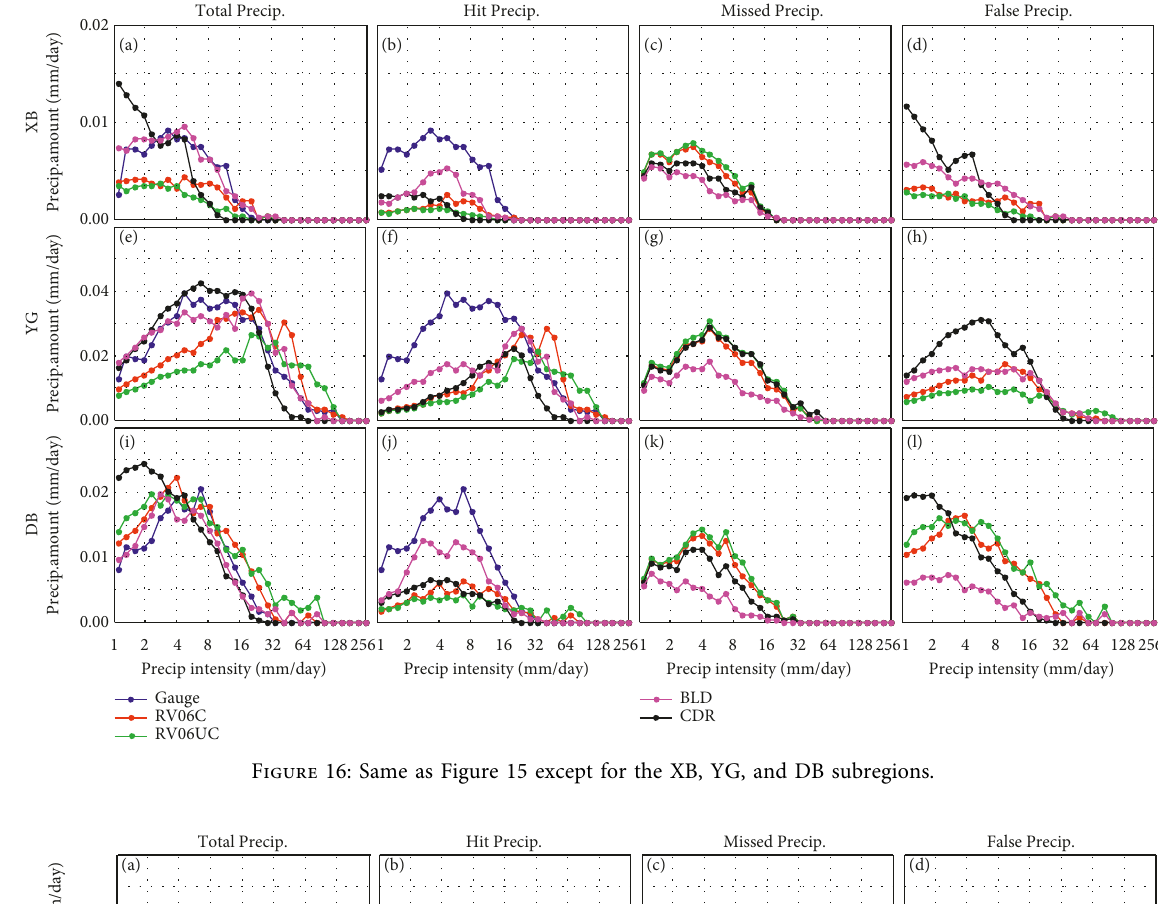
Figure 16: Same as Figure 15 except for the XB, YG, and DB subregions.